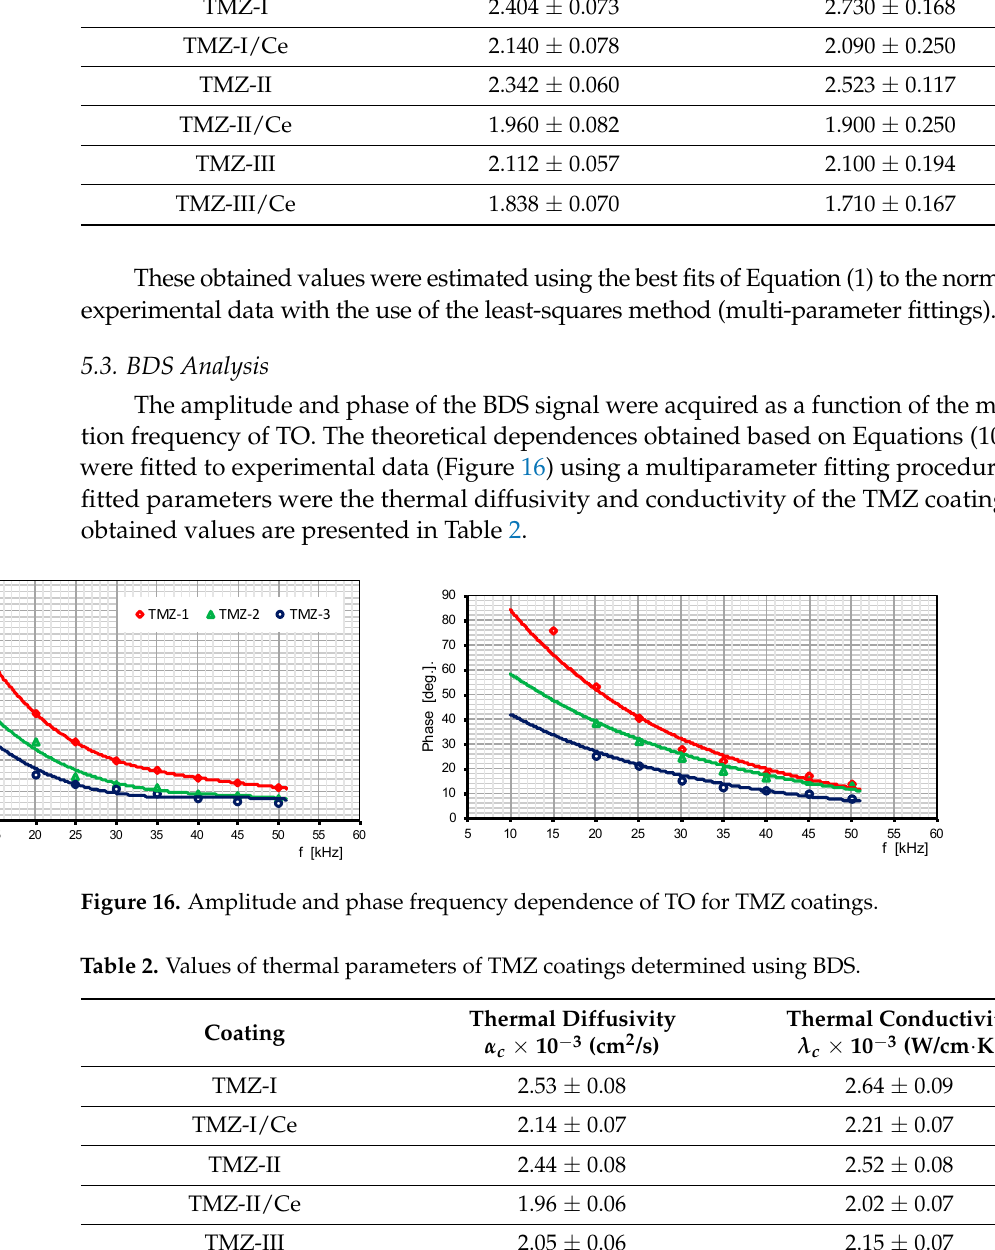
Table 1. Thermal parameters values for investigated TMZ coatings were determined using non- destructive photothermal radiometry.